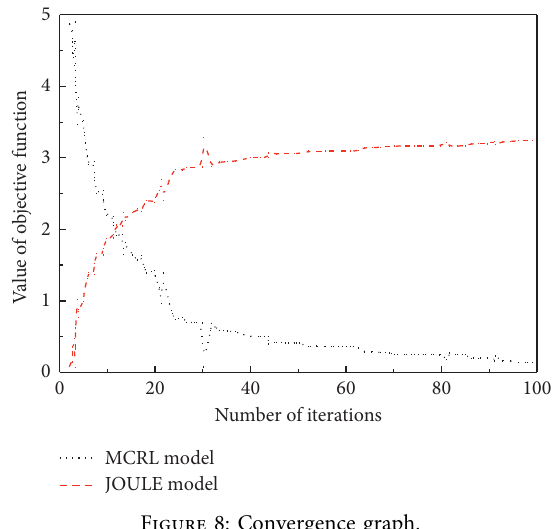
Figure 8: Convergence